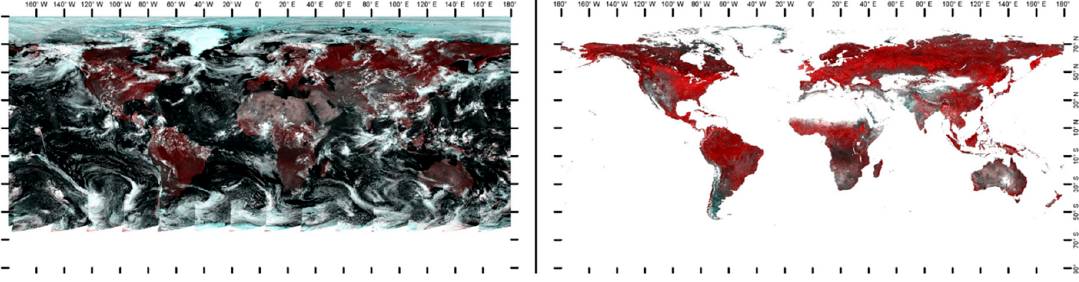
Figure 6. Impact of temporal compositing for the LTDR data. ( Left ) Daily images acquired on July 18, 2008. ( Right ) Monthly composite for July 2008 with the unburnable classes removed. In both cases, the RGB color composition used NIR, red, and red reflectances.